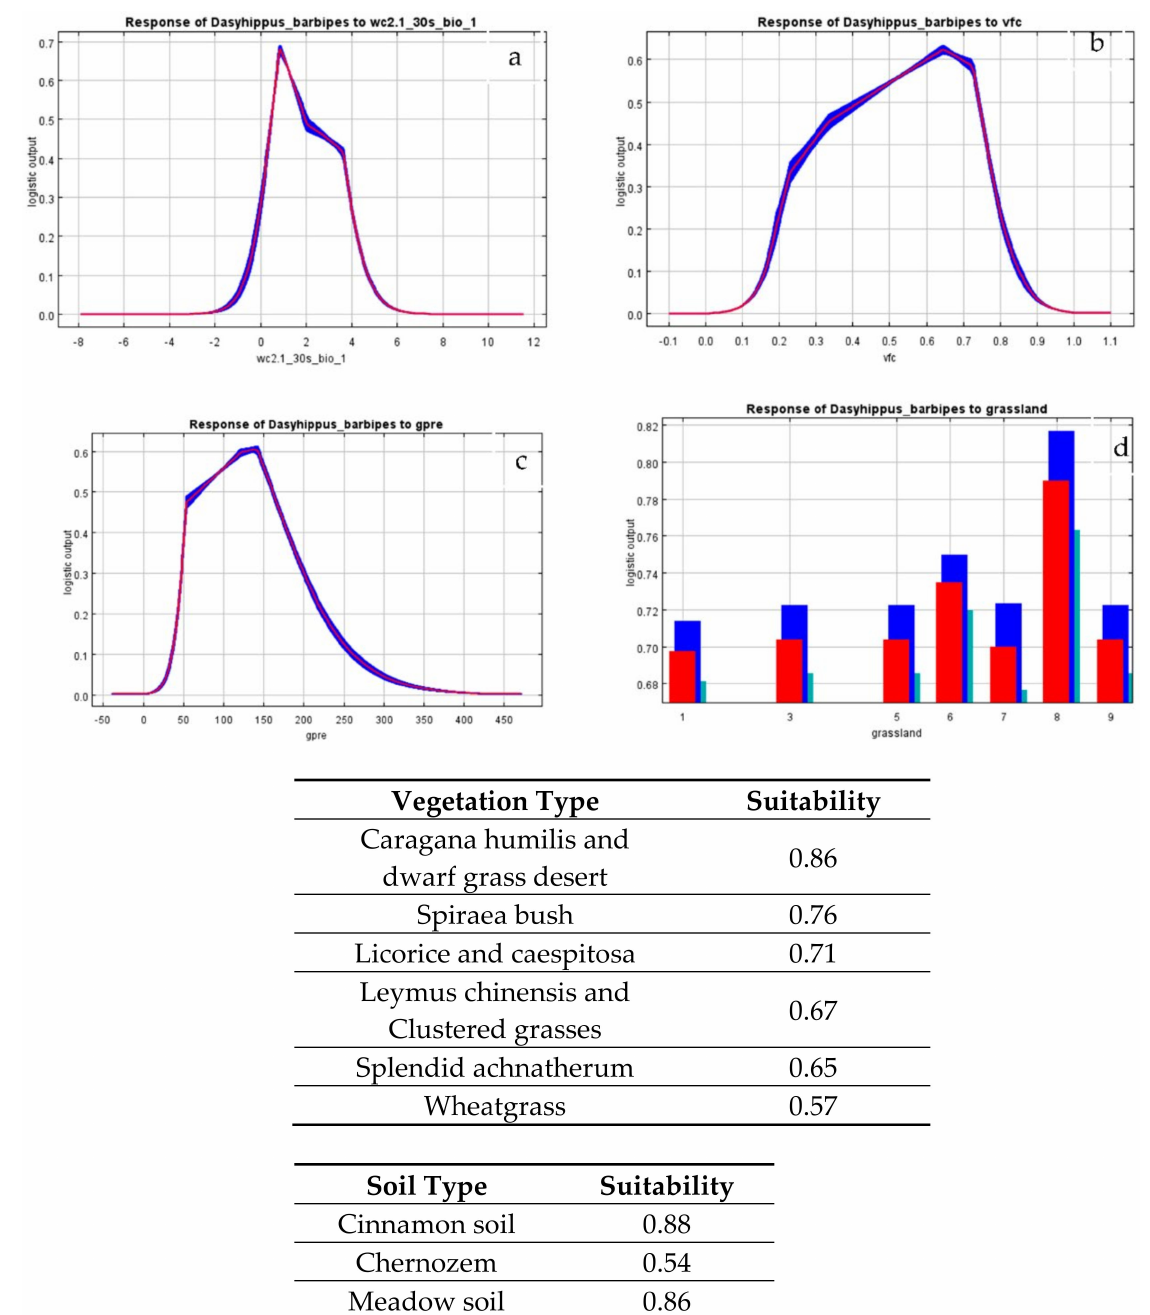
Figure 7. The response curves of the main habitat factors predicted by our high − density grassland locust dataset model: ( a ) mean annual temperature; ( b ) vegetation coverage; ( c ) precipitation in growth season; ( d ) grassland type. The response curves show the relationships between the prob- ability of occurrence of locusts and the habitat variables. The displayed values are the average of 10 repeated runs. The blue areas show the ± SD of the 10 repetitions. For each panel, the X axis represents the variable and the Y axis represents the probability of occurrence. Note: the grassland types were classified as follows: 1 = nongrassland area; 3 = other types of grassland; 5 = typical temperate grassland; 6 = temperate desertification; 7 = temperate grassland; 8 = temperate desert; 9 = background